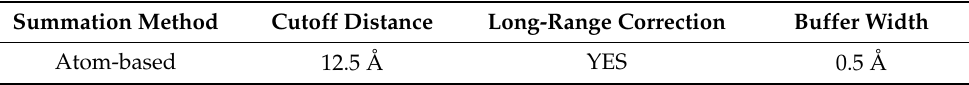
Figure 4. Schematic diagram of the initial model: ( a ) Model I ( b ) Model II. Table 4. Model II force field